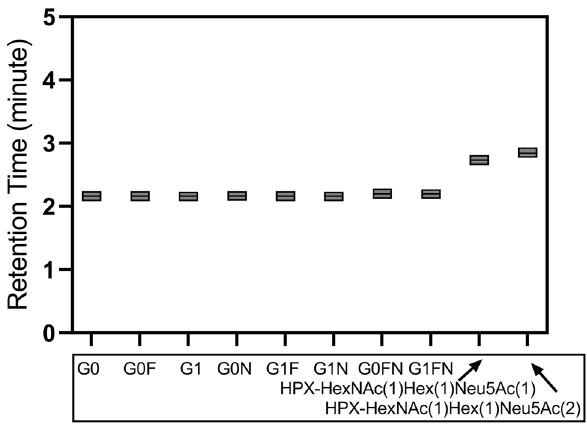
Figure 2. Observed retention times of the IgG and HPX glycopeptides. Each box represents the elution time spread ( y -axis) of the indicated glycopeptide ( x -axis), and the mean RT is indicated by a line in the box.